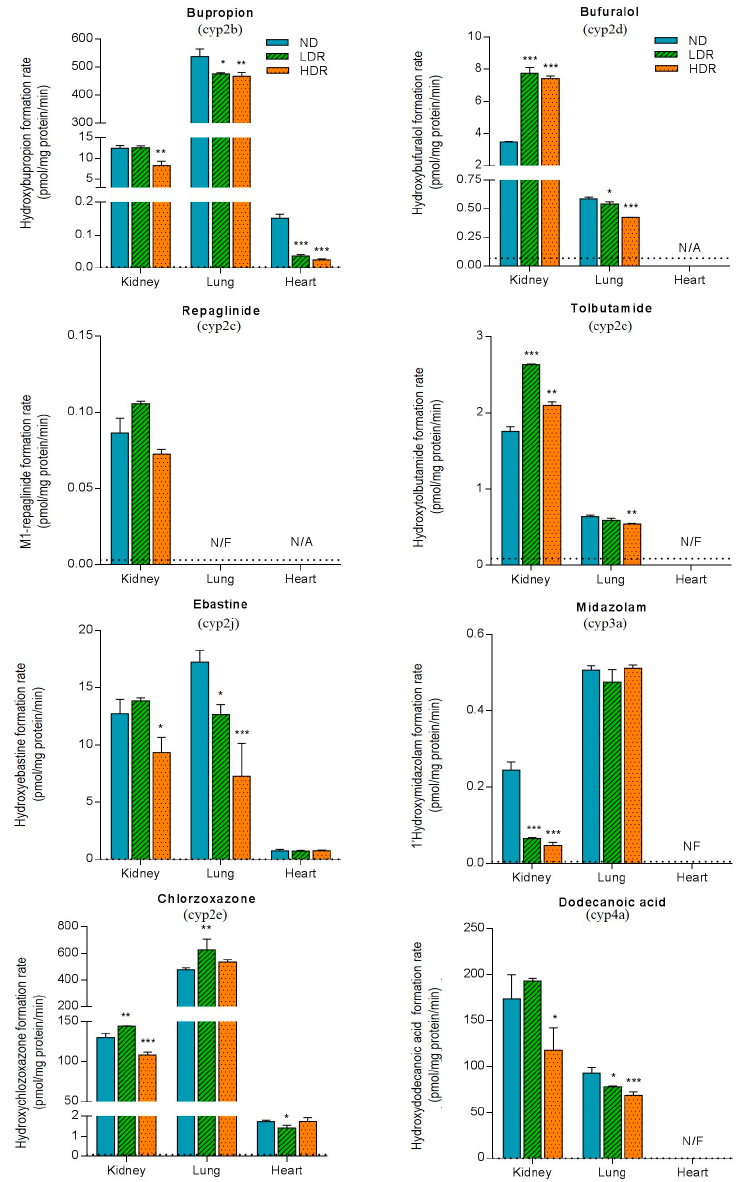
Figure 3. Extrahepatic cyp450 microsomal activities for cyp2b (bupropion), cyp2c (tolbutamide and repaglinide), cyp2d (bufuralol), cyp2e (chlorzoxazone), cyp2j (ebastine), cyp3a (midazolam) and cyp4a (dodecanoic acid) measured in the kidneys, lungs and heart in C57BL6 mice fed a normal diet (ND) or a HFD (LDR, low-diet responders; and HDR, high-diet responders after an eight-week period). Bars and error bars represent the mean ± SD, respectively. LDR or HDR vs. ND; * p < 0.05, ** p < 0.01, *** p < 0.001. N/F; activity not found, N/A; Not Available (in vitro incubation could not be determined) and dotted line represents the limit of quantification.